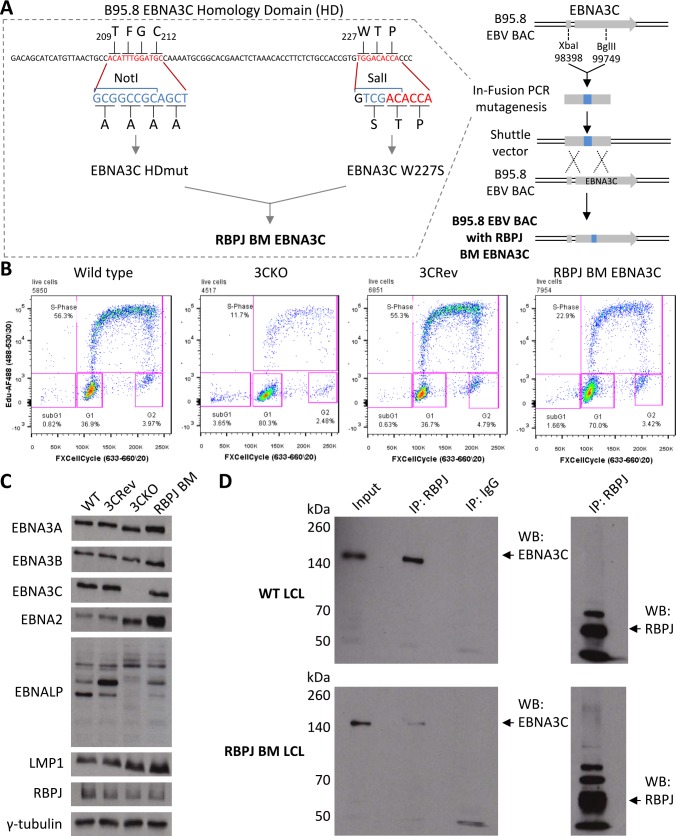
Construction of recombinant EBV with RBPJ binding mutant EBNA3C and validation of established LCL.(A) Schematic representation of the construction of the EBV recombinant encoding the EBNA3C binding mutant (EBNA3C BM) incapable of binding RBPJ. The N-terminal XbaI/BglII fragment of EBNA3C was excised from the B95.8 EBV bacterial artificial chromosome (BAC) and used as template for In-Fusion based mutagenesis. The two RBPJ binding sites, 209TFGC and 227WTP, of EBNA3C were mutated to 209AAAA and W227S based on previous studies [11,42]. The nucleotide sequence of the wild type EBV BAC is shown in red and the mutated sequence in blue. Mutations were introduced in a two-step In-Fusion based mutagenesis process, with the 209AAAA mutation (homology domain (HD) mutant) generated first, introducing a NotI restriction site, followed by the W227S mutation, introducing a SalI restriction site. The resulting RBPJ binding mutant EBNA3C was reintroduced into the B95.8 EBV BAC by RecA mediated homologous recombination. (B) Cell proliferation assay at day 36 after infection of primary B cells with wild type, EBNA3C knockout (3CKO), EBNA3C revertant (3CRev) or RBPJ binding mutant EBNA3C (RBPJ BM) recombinant viruses. Live cells were analysed for proliferation by measuring EdU incorporation and DNA content by FxCycle Far red DNA stain. Gates show populations of cells in sub-G1, G1, S-phase or G2/M phase. (C) Immunoblot for EBNA3A, EBNA3B, EBNA3C, EBNA2, EBNALP, LMP1, RBPJ and γ-tubulin on LCLs established from primary B cell infection with wild-type (WT), EBNA3C Revertant (3CRev), EBNA3C knockout (3CKO) and RBPJ binding mutant EBNA3C (RBPJ BM) EBV. (D) Immunoprecipitation (IP) of RBPJ or antibody isotype control (IgG) in WT LCL or RBPJ BM LCL and western blotting (WB) for EBNA3C or RBPJ as indicated. Input represents 10% of lysate used in IPs and arrows indicate bands of EBNA3C or RBPJ.